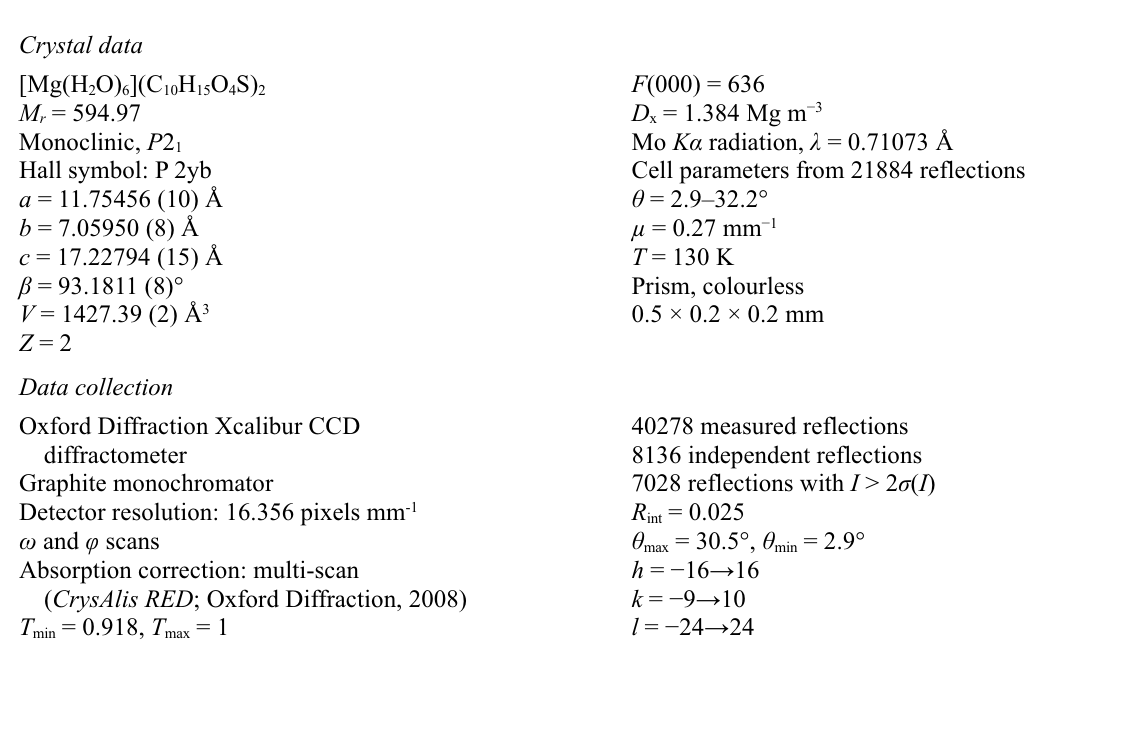
O) ](C H O S) . Displacement ellipsoids are plotted at the 50% probability level and H 2 6 10 15 4 2